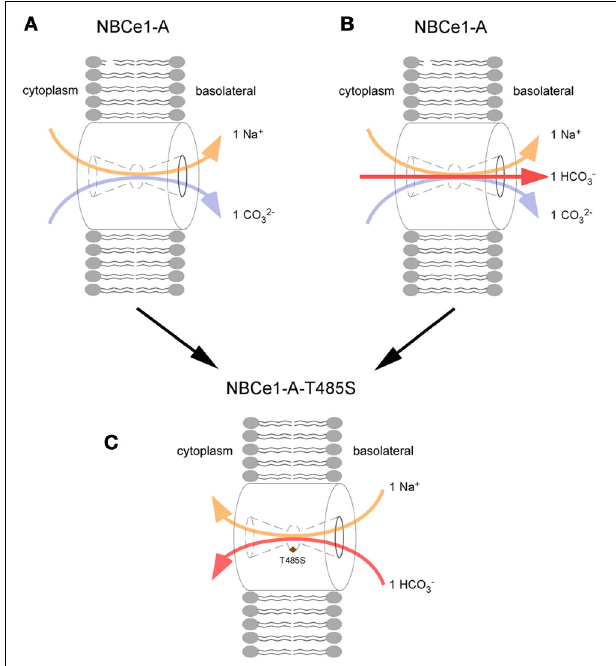
FIGURE 3 | Loss of electrogenicity caused by the T485S pRTA mutation. The charge transport stoichiometry of NBCe1-A in the human proximal tubule is unknown and 2 potential models are depicted: In the 1:2 charge transport stoichiometry mode (A) , wt-NBCe1-A is modeled to lose its electrogenecity because the T485S mutant (C) preferentially transports Na + -HCO − 3 rather Na + -CO 2 − 3 . i.e., the anion interaction site favors HCO − 3 rather than CO 2